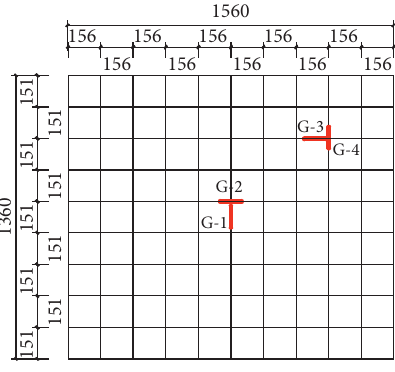
Figure 7: Layout of reinforcement strain gauge.